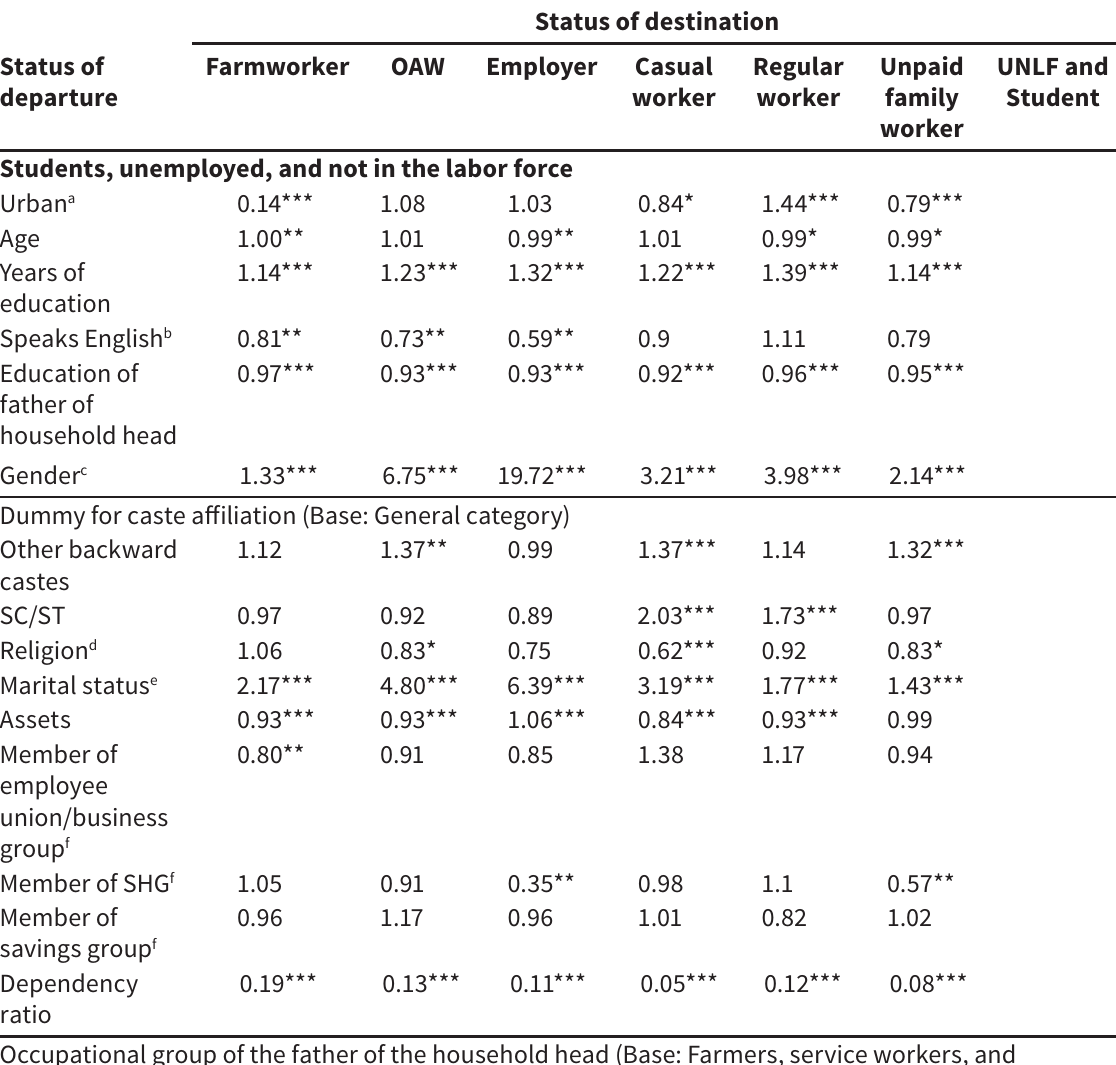
Table A3 Mobility and individual characteristics